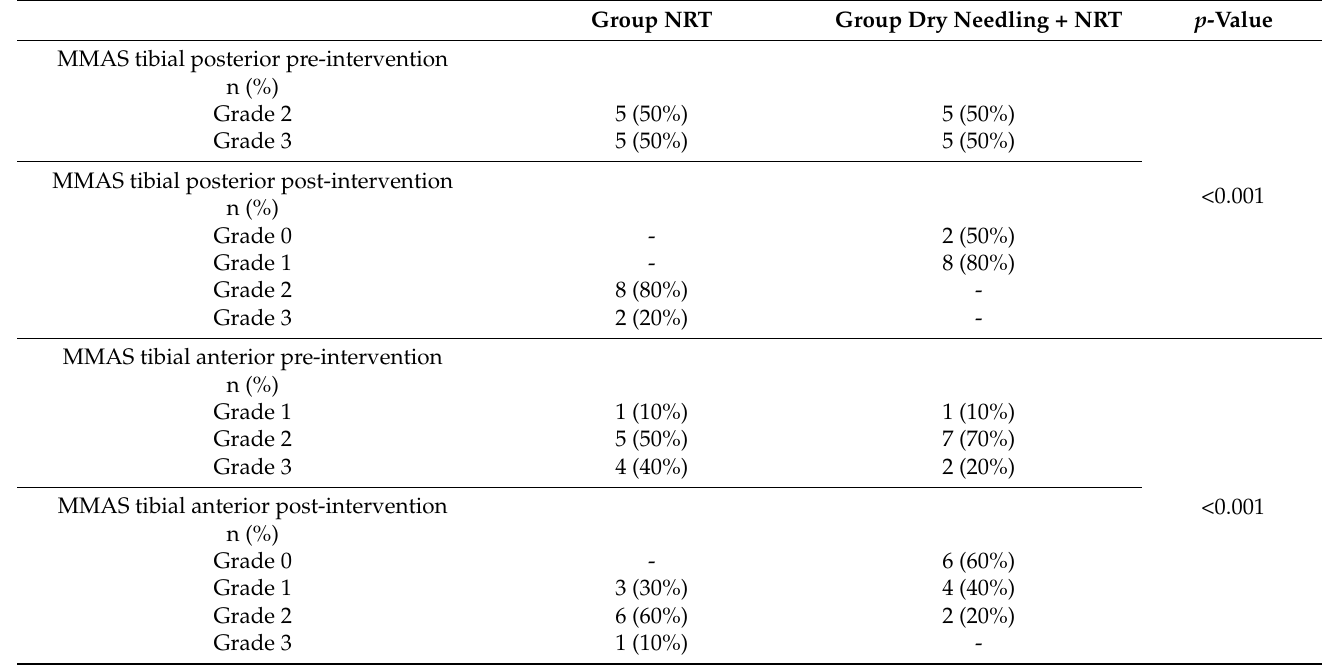
Table 2. Changes in MMAS before and after intervention in both groups. Group NRT Group Dry Needling + NRT p